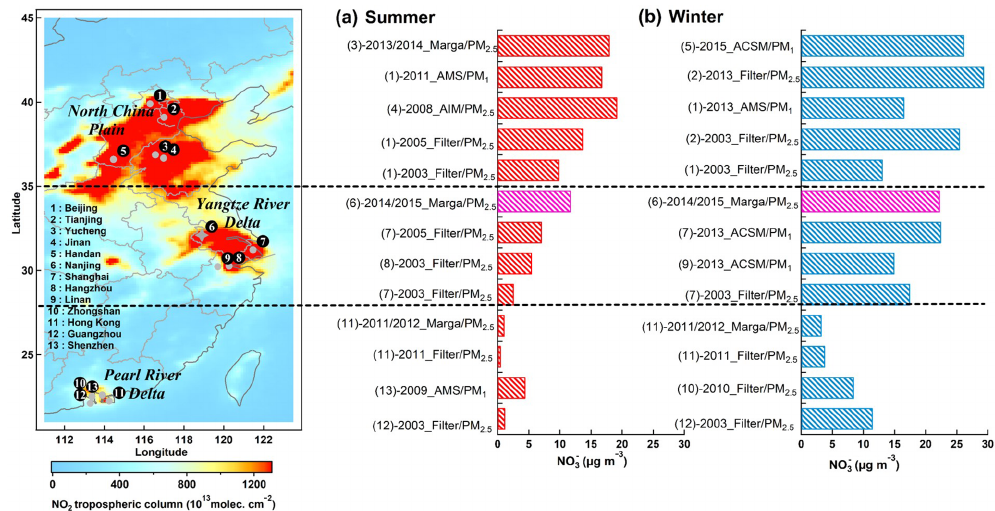
Figure 1. Average mass concentrations of particulate nitrate at different sampling sites in (a) summer and (b) winter. The left panel shows the map color coded by 2 years (2014–2015) of averaged tropospheric NO 2 from the OMI satellite (http://www.temis.nl/airpollution/no2.html, last access: 11 January 2018). The pink bars are for this